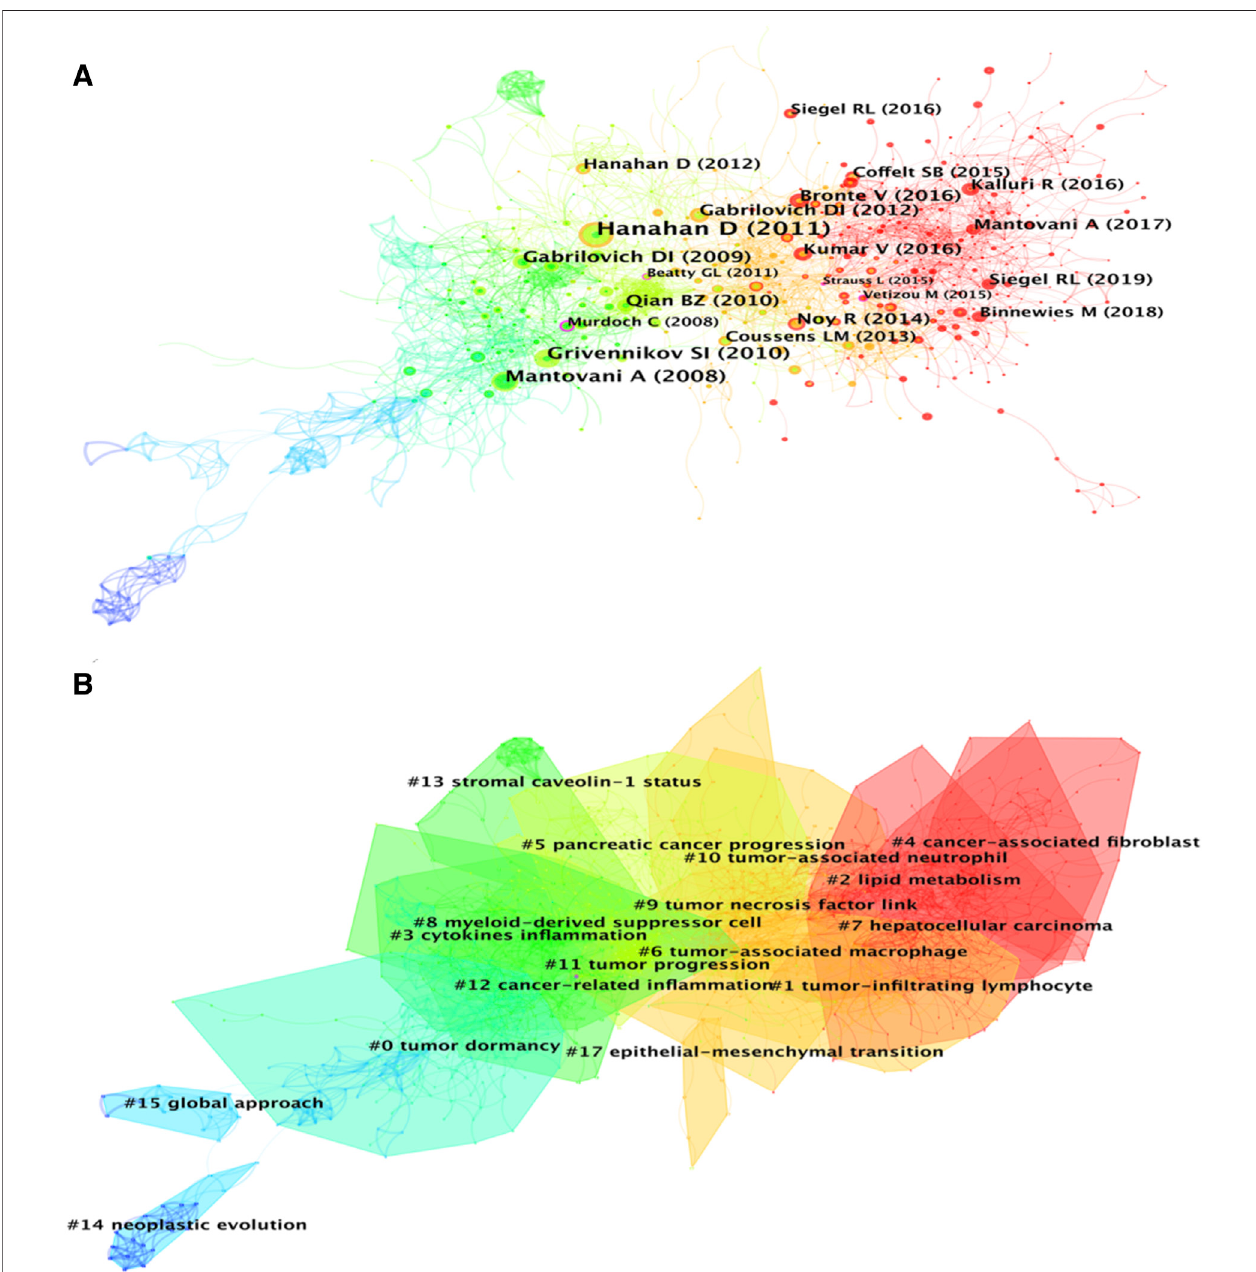
FIGURE 5 | (A) Co-citation co-occurrence knowledge map of the in fl ammatory tumor microenvironment. (B) Co-citation clustering knowledge map of the in fl ammatory tumor microenvironment.